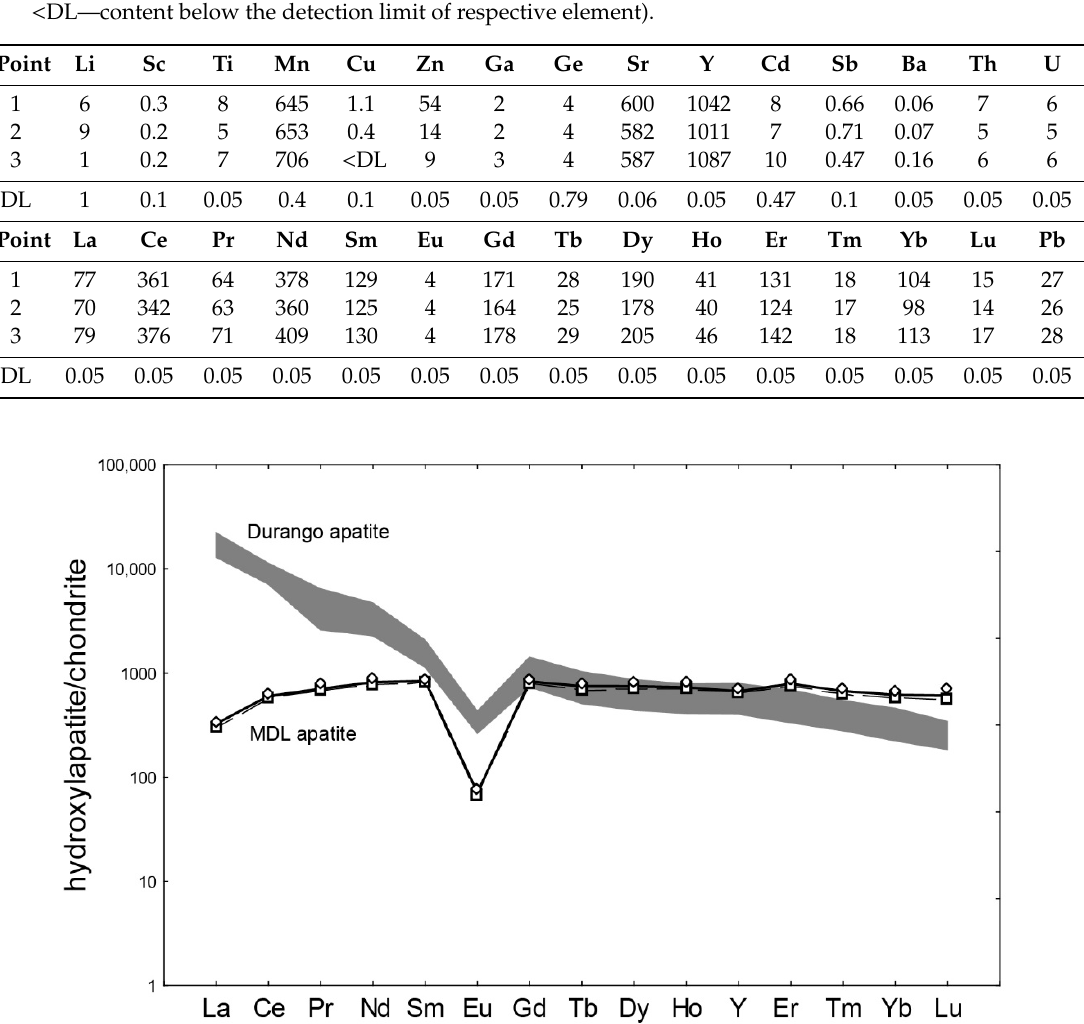
Figure 6. Chondrite-normalized REE patterns of hydroxylapatite from Muránska Dlhá Lúka measured by LA-ICP-MS (normalized on chondrite from [37]). Table 4. The FTIR spectrum band assignment of hydroxylapatite from Mur á nska Dlh á L ú ka according to